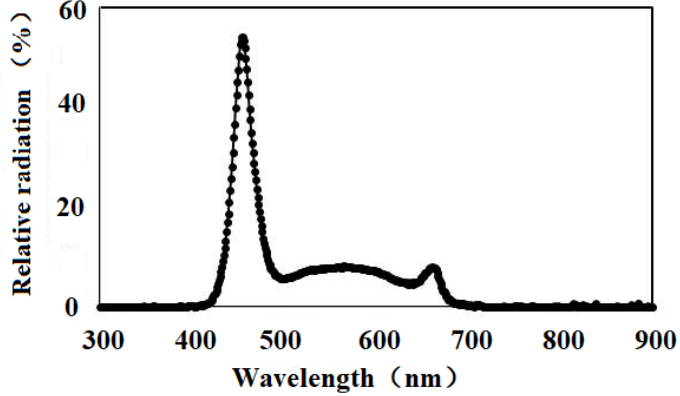
Figure 2. Relative spectral photon flux of polychromatic LEDs was used for the supplemental lighting treatment in this experiment. The wavelengths of the light sources were recorded at 240–800 nm with a spectrometer (SR9910-v7, Irradiant Ltd., Tranent, UK). A digital timer, dimmer, and transformer were used to maintain the light period and light intensity.